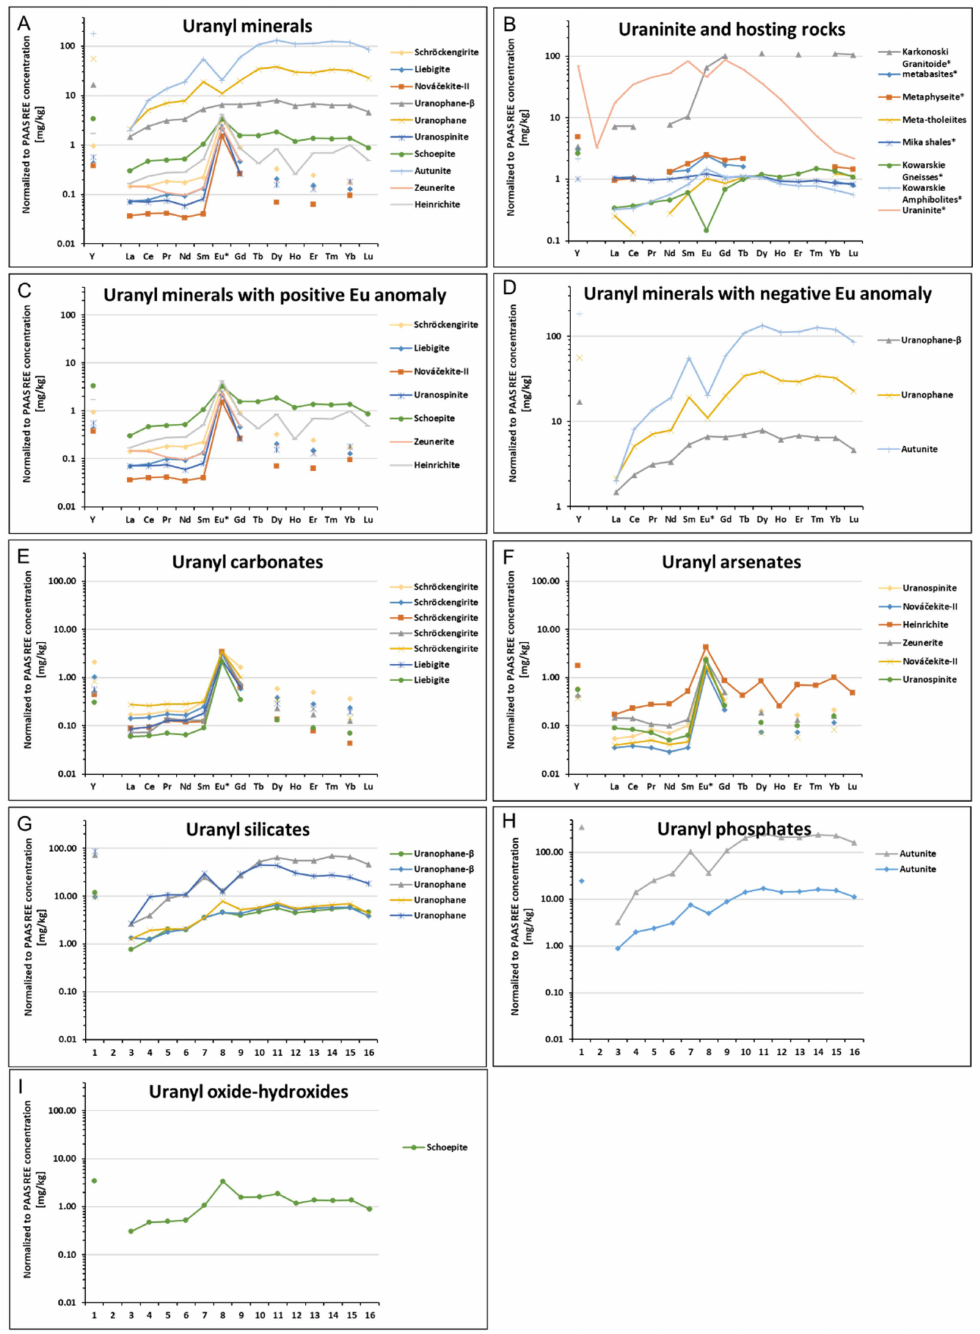
Figure 14. REE distribution patterns: ( A ) all uranyl minerals, ( B ) uraninite and surrounding rocks *, ( C ) first group of uranyl minerals, ( D ) second group of uranyl minerals, ( E ) uranyl carbonates, ( F ) uranyl arsenates, ( G ) uranyl silicates, ( H ) uranyl phosphates, and ( I ) uranyl oxide-hydroxides. * Literature